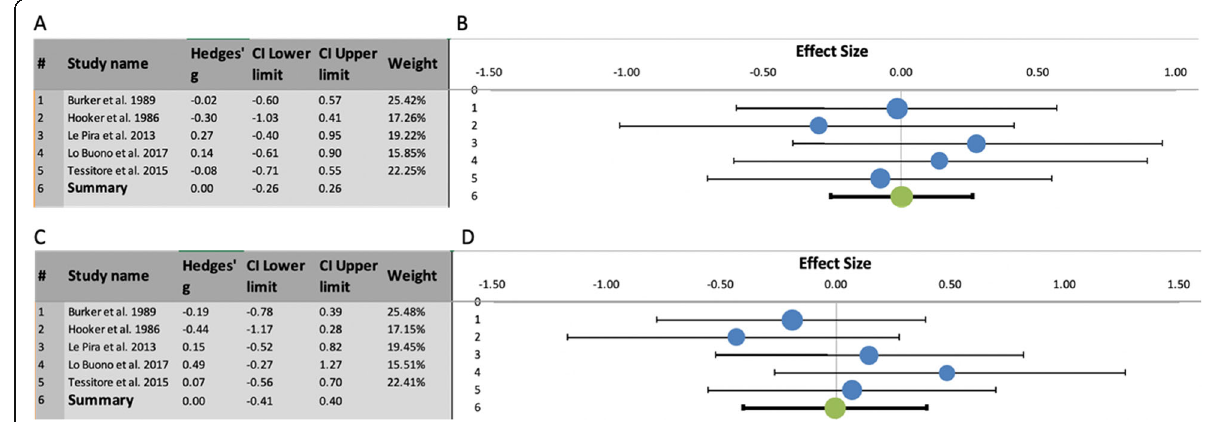
Fig. 5 a : Summary results of meta-analysis regarding TMT-A performance differences between migraine with aura and migraine without aura, including Hedges ’ g, Confidence Intervals (CI) and relative weight of each study. b : Forest plot showing the effect size (with CI) of individual studies and, below, the combined effect size with its CI (in black). c : Summary results of meta-analysis regarding TMT-B performance differences between migraine with aura and migraine without aura, including Hedges ’ g, CI and relative weight of each study. d : Forest plot showing the effect size (with CI) of individual studies and, below, the combined effect size with its CI (in